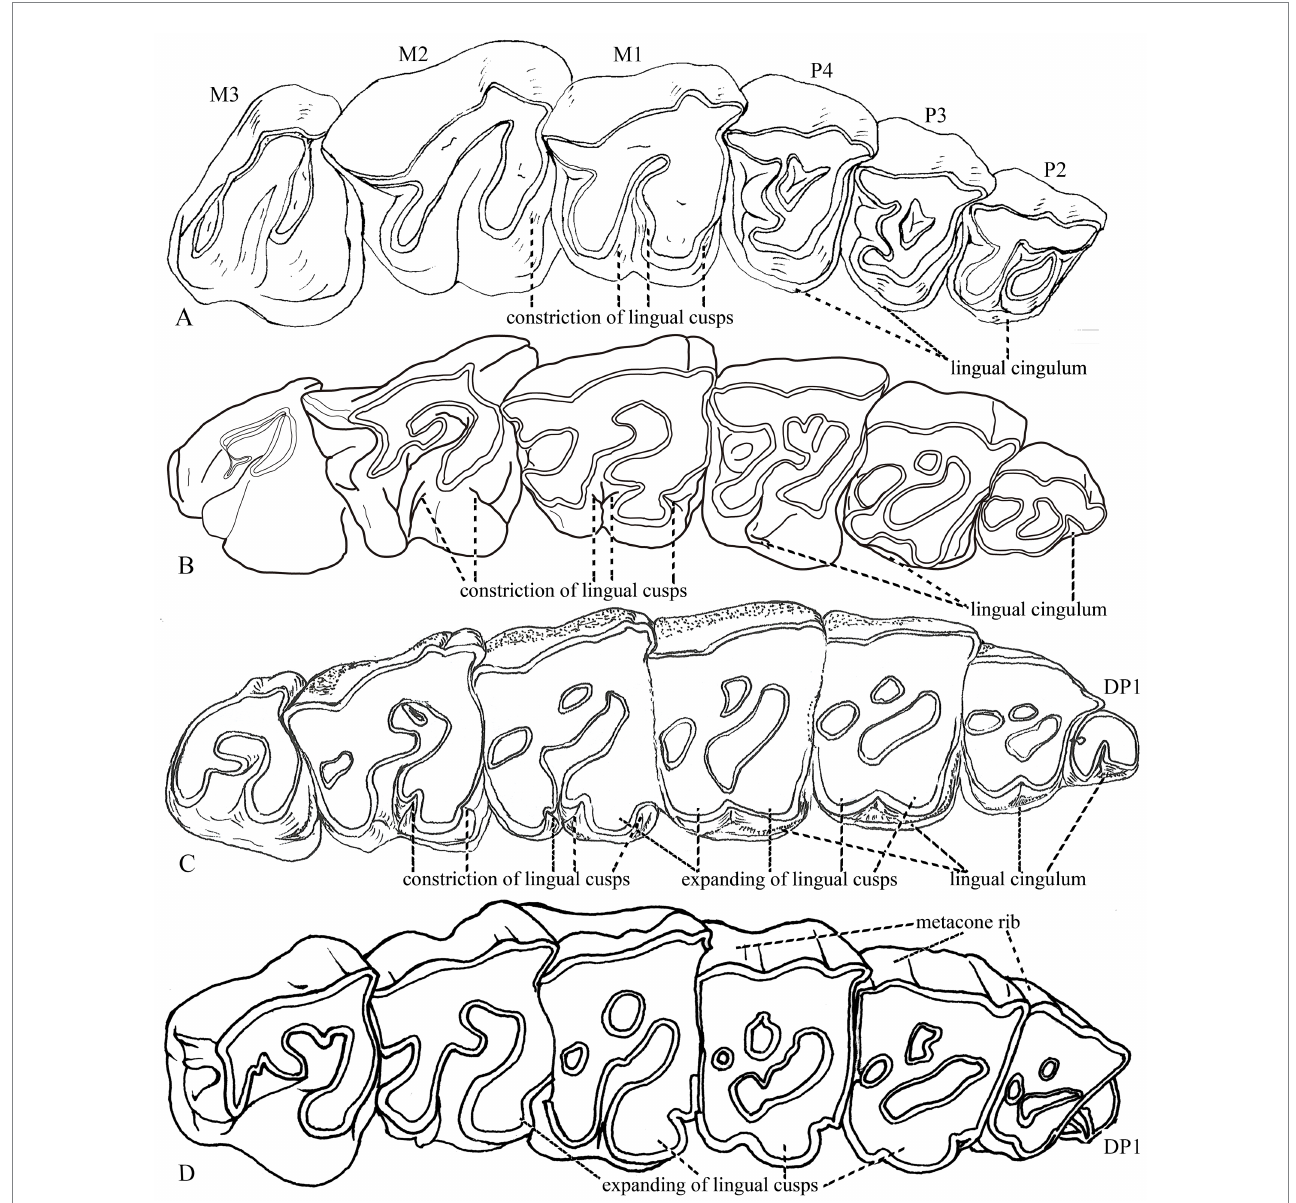
FIGURE 6 Upper cheek teeth of rhinocerotids. (A) Trigonias osborni , DMNH 414, based on a specimen by Gregory and Cook (1928). (B) Teleoceras fossiger , Osborn (1904), Figure 21. (C) Acerorhinus hezhengensis , HMV 0639, new specimen. (D) Rhinoceros unicornis , IVPP OV 1383, new specimen. Not to